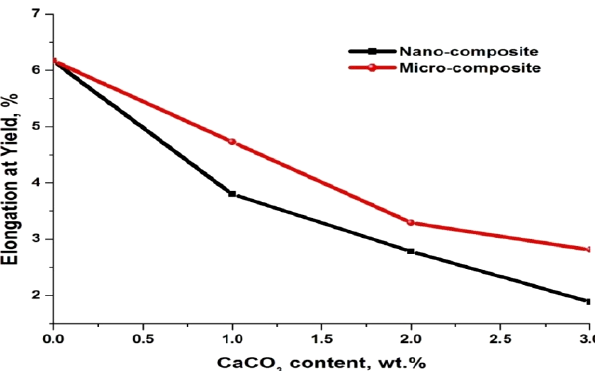
Fig. 8. Variation of elongation of micro- and nano-composites with filler loading at yield.